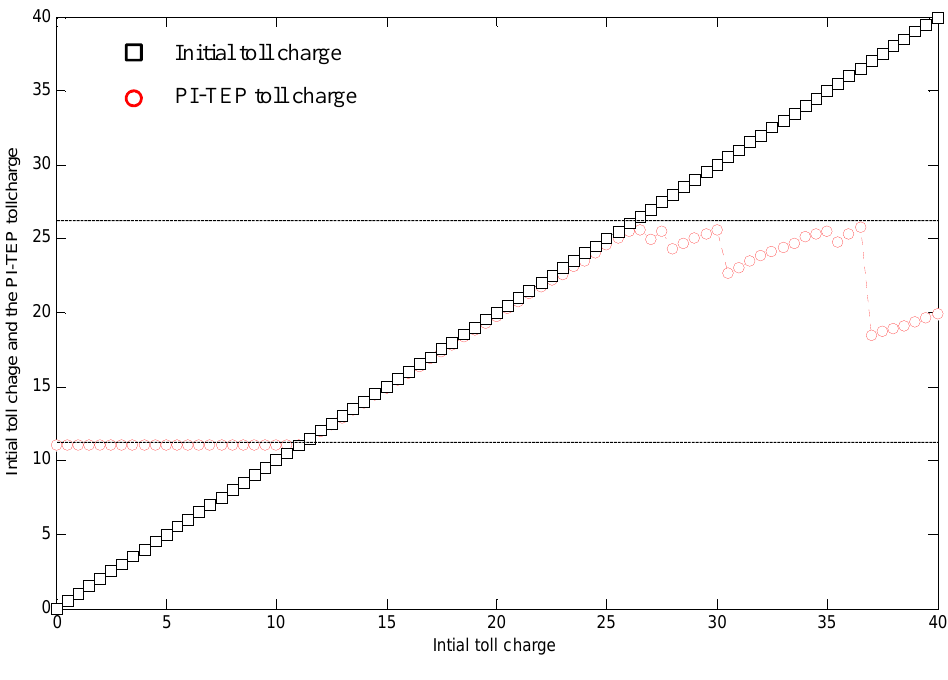
Figure 2. Toll charge before and after